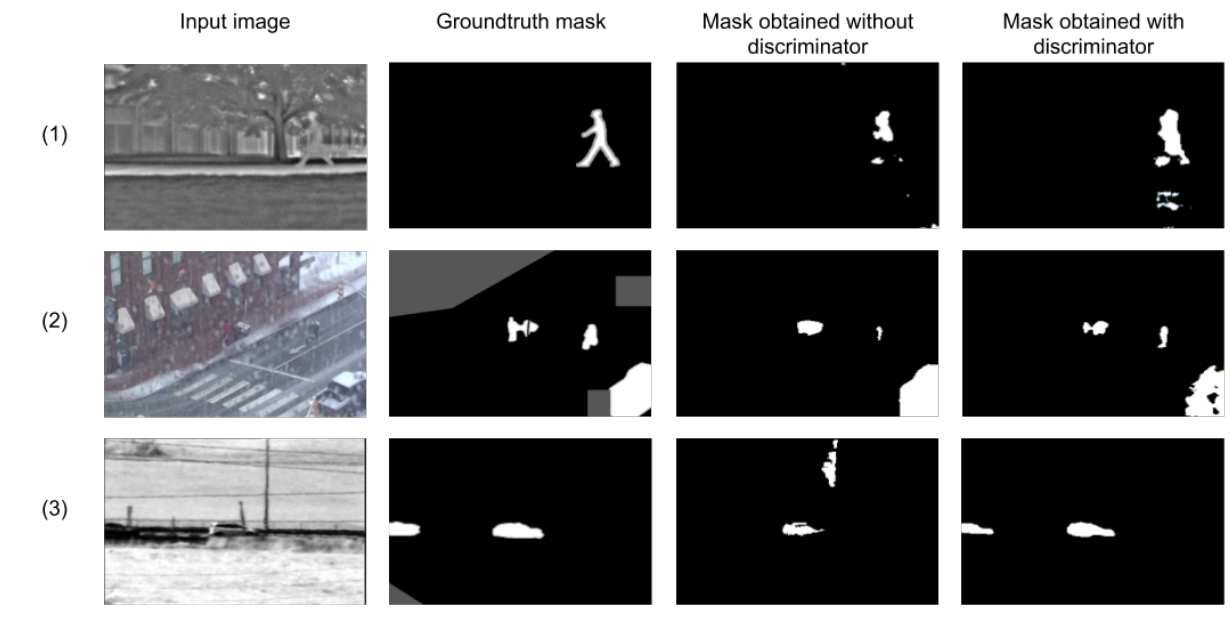
Figure 5. Examples of the masks generated by the network with and without the usage of a discrim- inator. First row: frame from the sequence “Park” (“thermal” category). Second row: frame from “wetSnow” (“badWeather” category). Third row: frame from “turbulence3” (“turbulence” category). First column: the input image of the frame is shown. Second column: its corresponding ground truth. Finally, the third column is for results obtained without a discriminator, and the last column shows results obtained using a